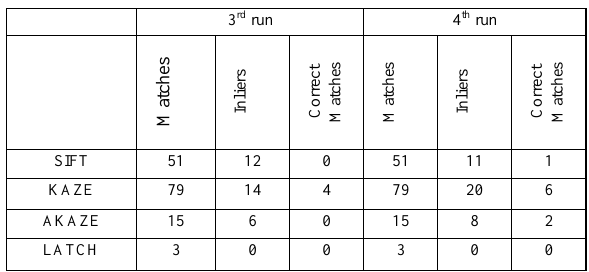
Table 5 Matching results of scene 2 between aerial